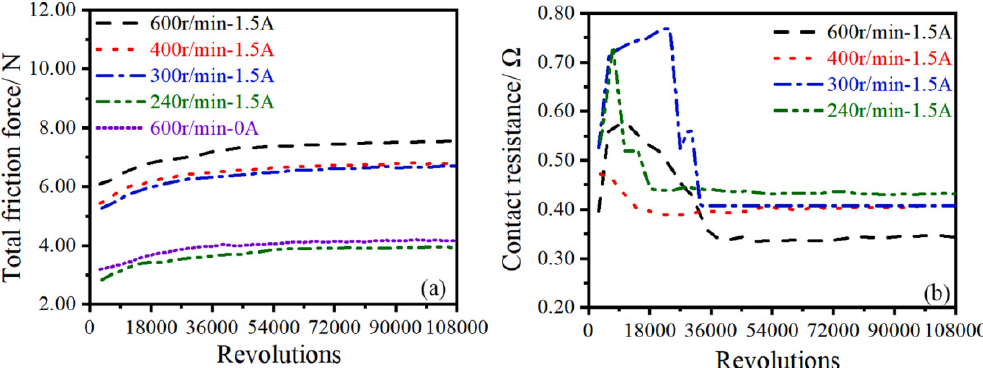
Figure 7. The effect of the rotation speed on the real-time ( a ) total friction force and ( b ) contact resistance [54].